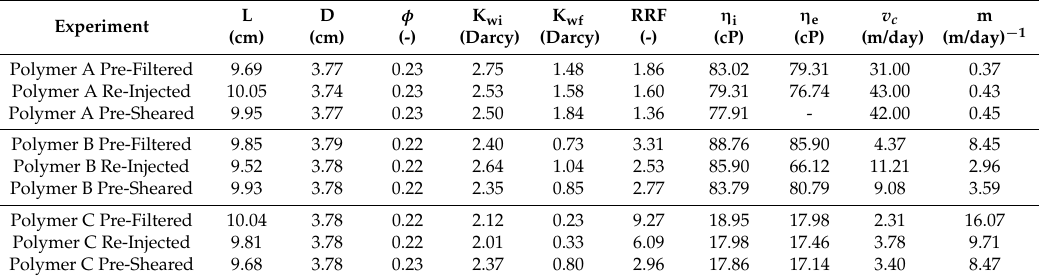
Table 5. Cores and viscoelastic properties of concentrated polymers A, B and C at concentration of 4000, 3000 and 1000 ppm,